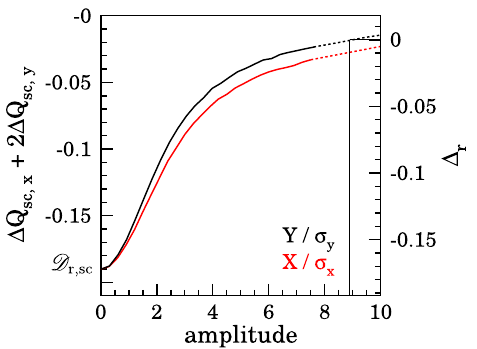
2 Δ Q FIG. 10. Resonance detuning Δ Q , and Δ r as a sc ; x þ sc ; y function of amplitudes ð 0 ; Y Þ (black curve), and ð X; 0 Þ (red curve) including chromaticity. The working point is Q x 0 ¼ 6 . 104 ; the vertical line corresponds to the halo edge of Y ∼ 9 σ y . The amplitudes are computed at the location of the vertical wire scanner